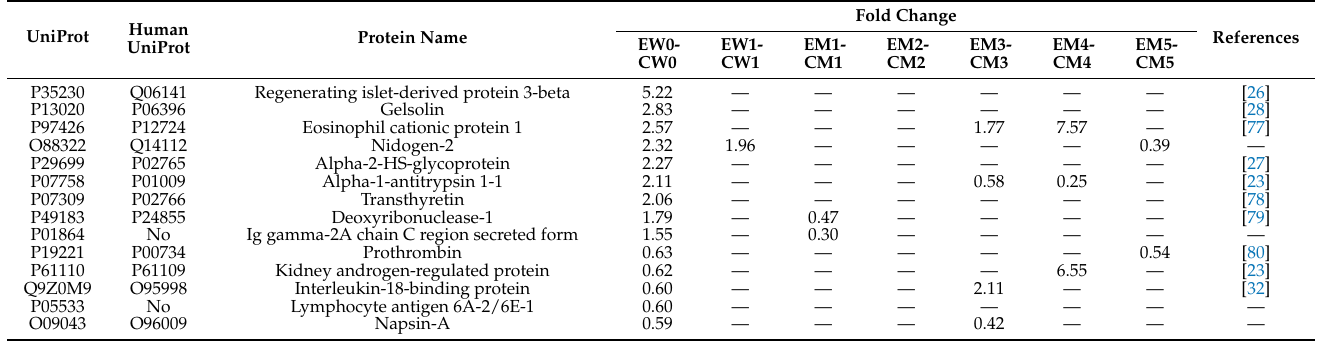
Table 2. Details of differential proteins between the experimental group and the control group at different time